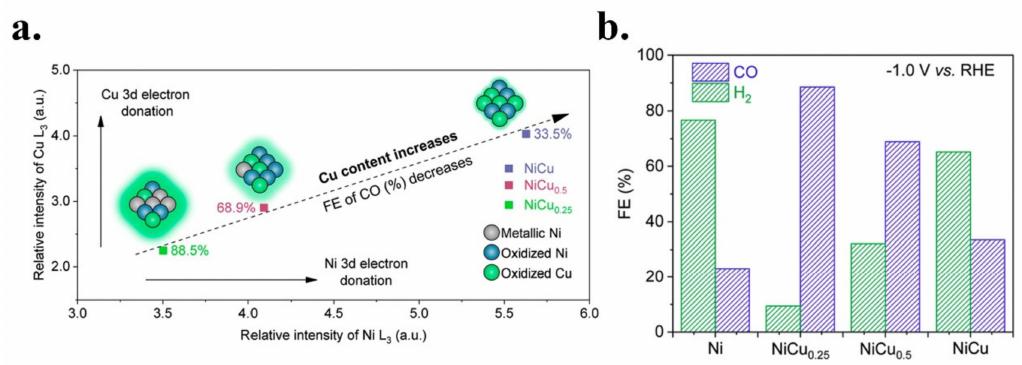
Figure 21. ( a ) Decrease in catalytic activity with increasing Cu content and ( b ) comparison of the electrochemical perfor- mance at − 1.0 V vs. RHE of catalysts with different Cu to Ni ratio. Adapted from